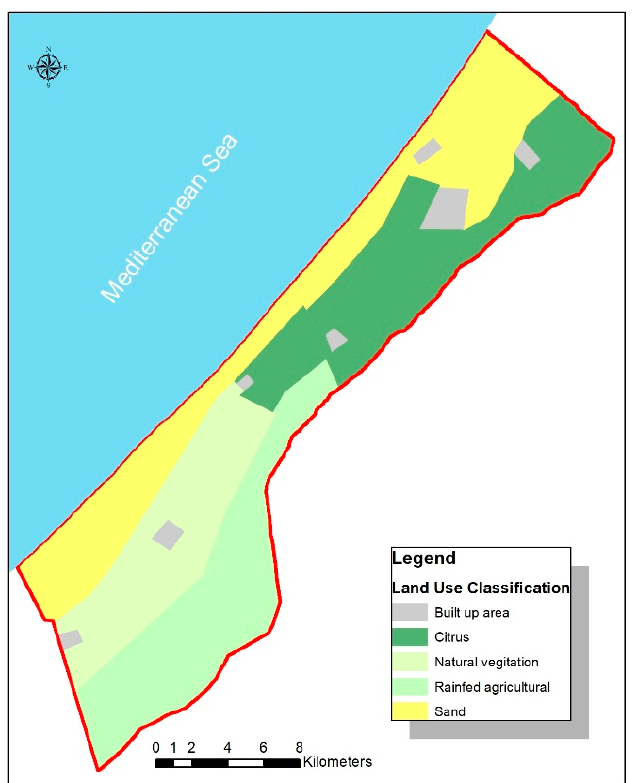
Figure 3. Land use map produced for the year 1935.